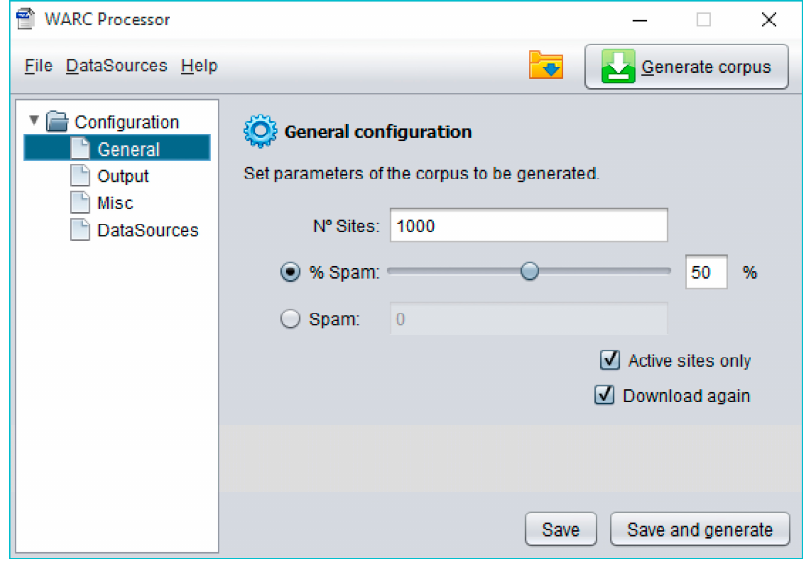
Figure 5. General configuration tab in WARCProcessor.